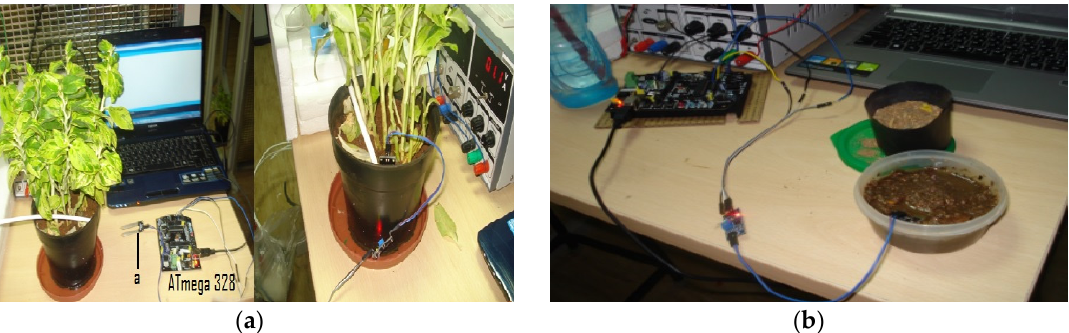
Figure 5. ( a ) Soil moisture sensor and pH sensor installed and tested; ( b ) soil moisture sensor placed in panchagavya.